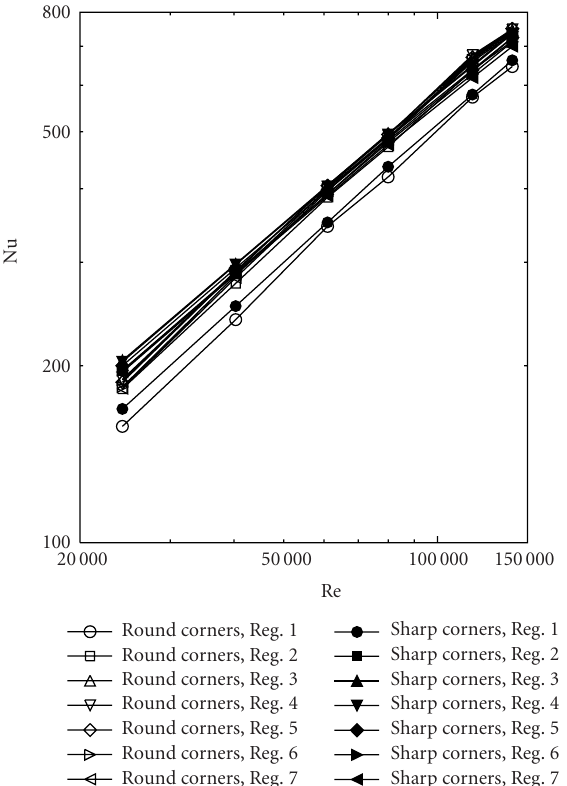
Figure 8: Comparison between the numerical results for sharp- and round-corner ribs with 20% blockage ratio ( e/D h = 0 . 2, P/e = 10).